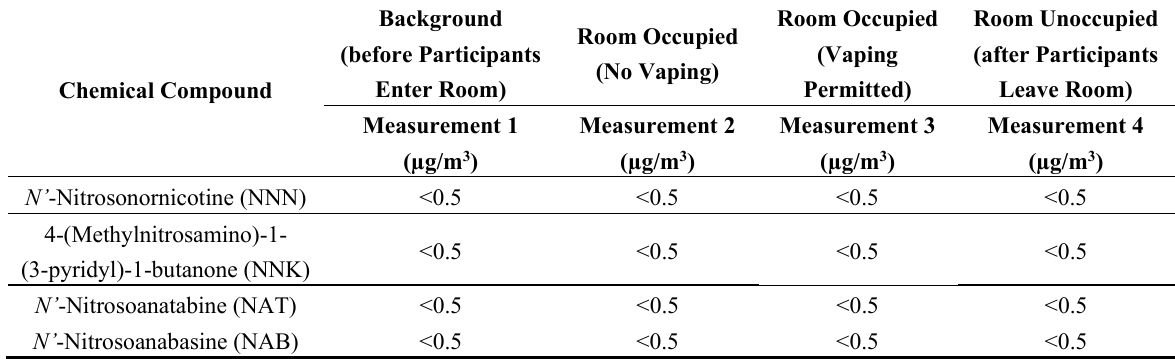
Table 4. Average indoor air concentrations of TSNAs (µg/m 3 ) measured before, during and after use of e-cigarettes from two independent sampling